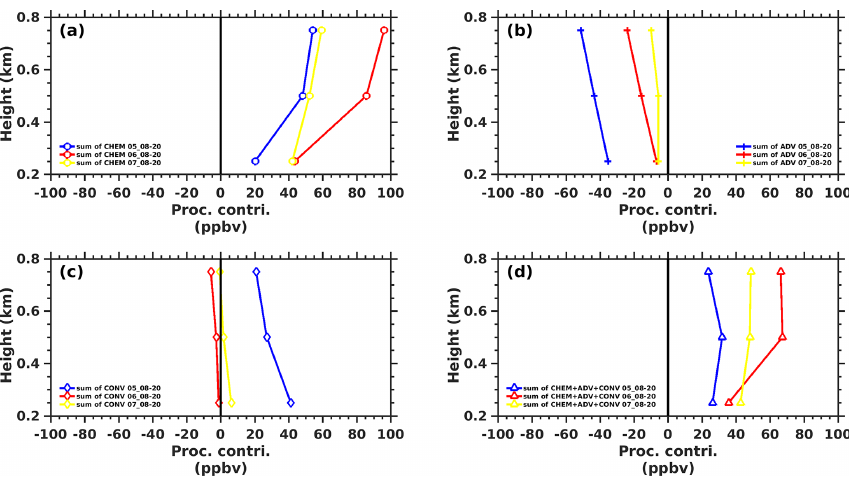
Figure 8. The vertical profiles of accumulative (a) CHEM, (b) ADV, (c) CONV, and (d) CVC (CHEM+ADV+CONV) during the periods from 08:00 to 20:00 on 5–7